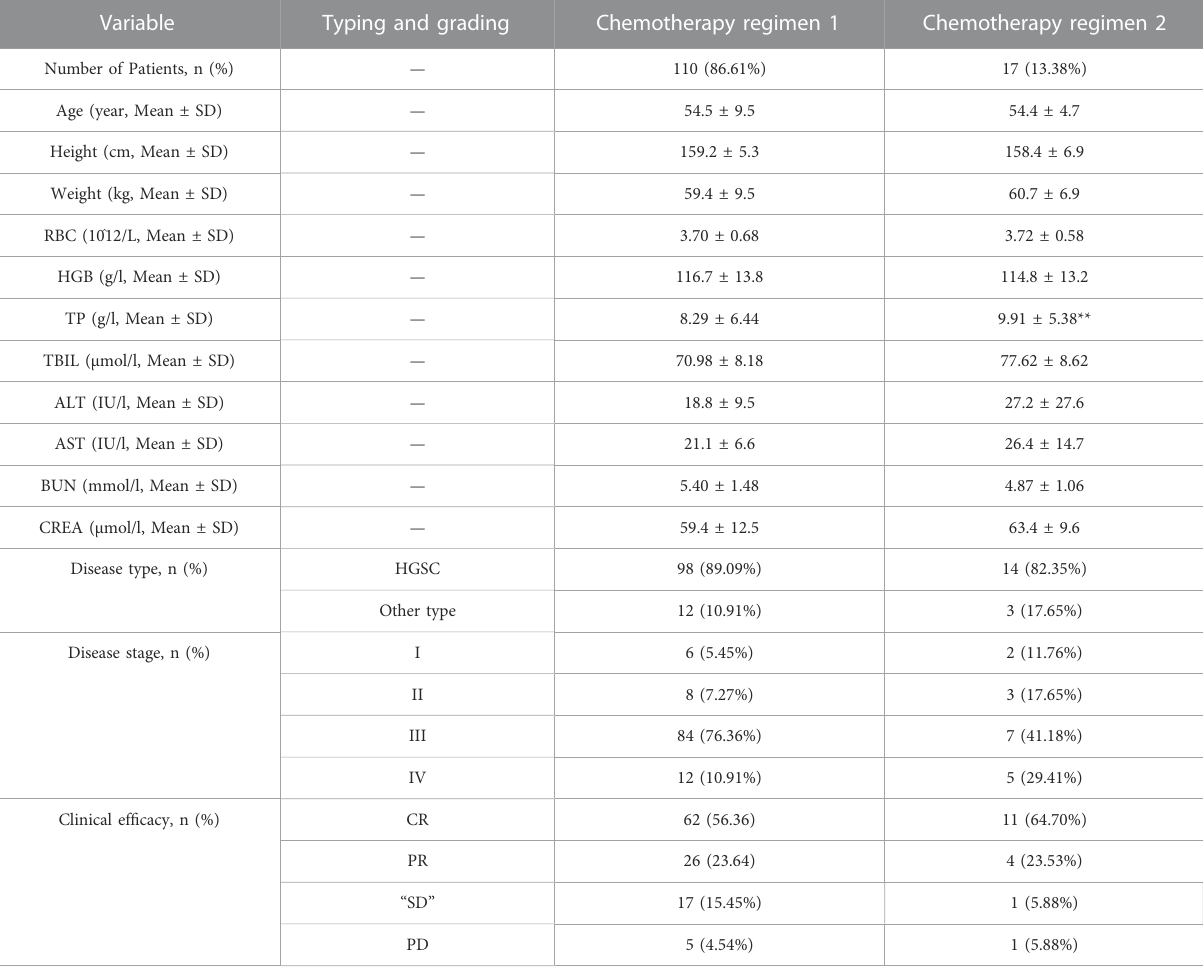
TABLE 1 Demographic and clinical characteristics of carboplatin-treated ovarian cancer patients. Variable Typing and grading Chemotherapy regimen 1 Chemotherapy regimen 2 Number of Patients, n